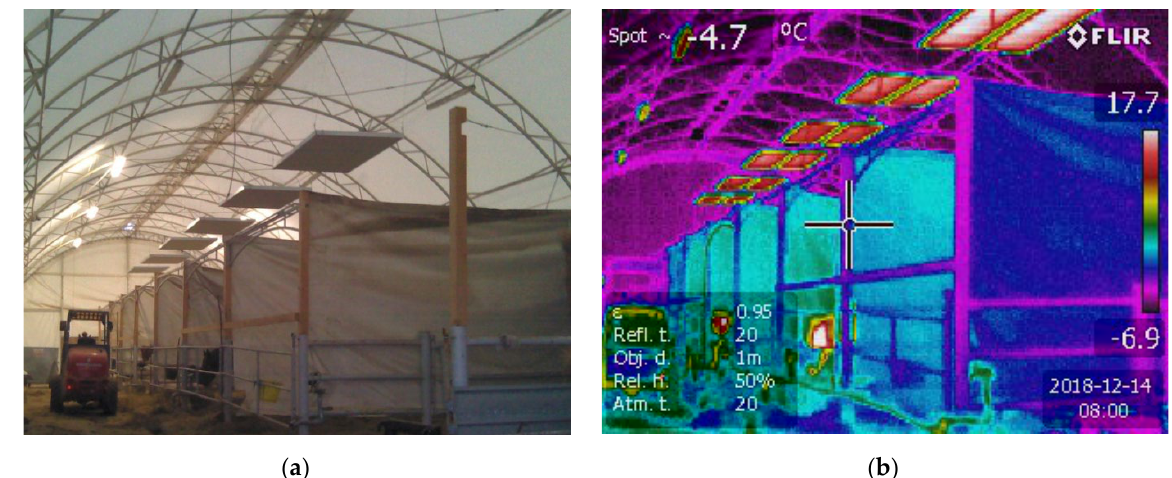
Figure 1. Normal (a) and FLIR thermocamera (b) imagines of trial place – six pens in hoop structure each with one IR heating panel suspended in arches of ceiling (Hutu,